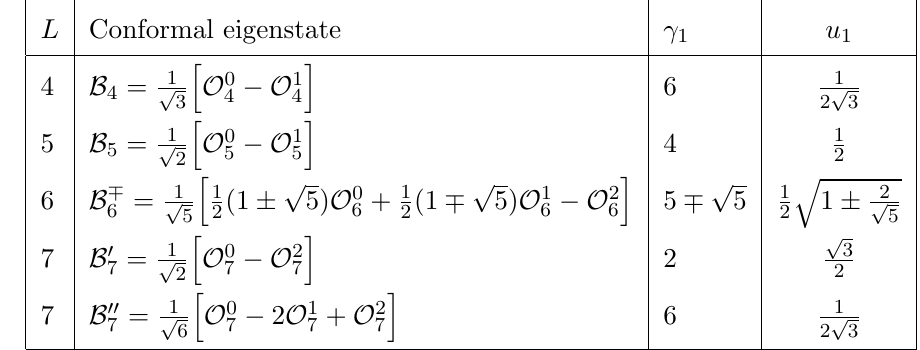
Table 1 . We list the two-impurity BMN operators that acquire a non-trivial anomalous dimension with length from 4 to 7. We denote the operators by B k (cid:13) 1 and the related Bethe Ansatz rapidity u